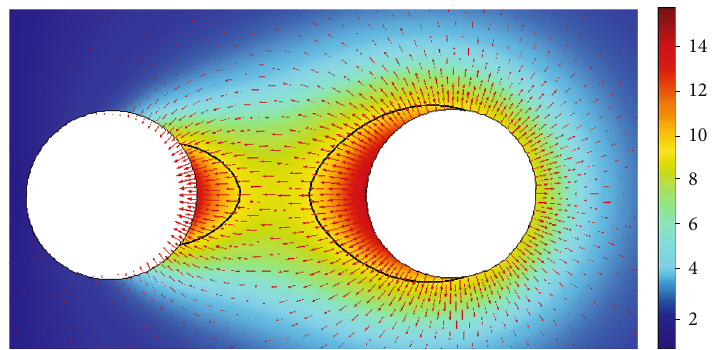
Figure 5: Velocity fi eld distribution of surrounding rock after excavation (unit: